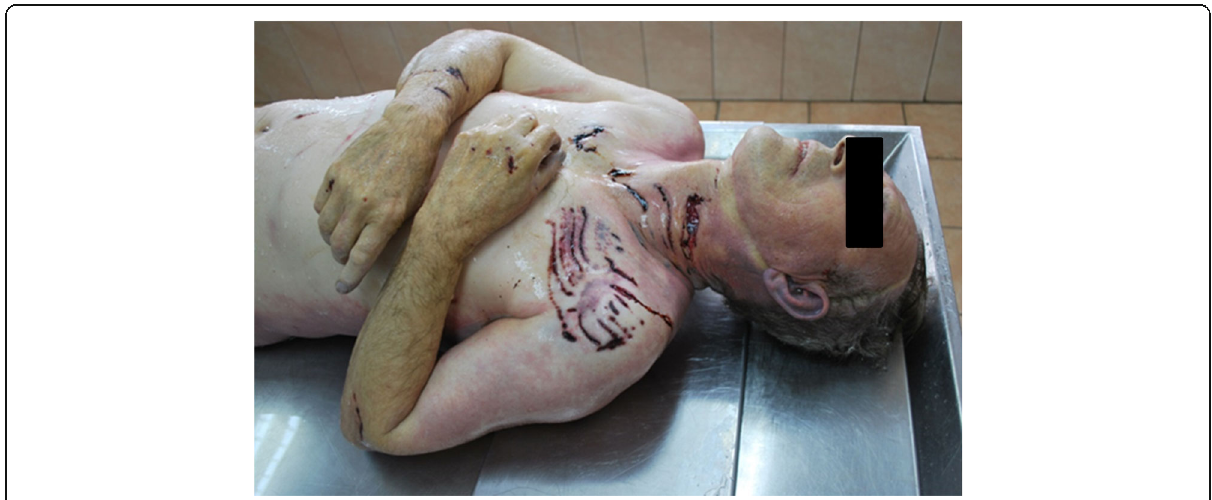
Fig. 1 Bite wounds on the neck, left shoulder, chest, and forearms. Legend: Examination of the body showed superficial injuries (abrasions, bruises, lacerations) on the neck, left shoulder, chest, and